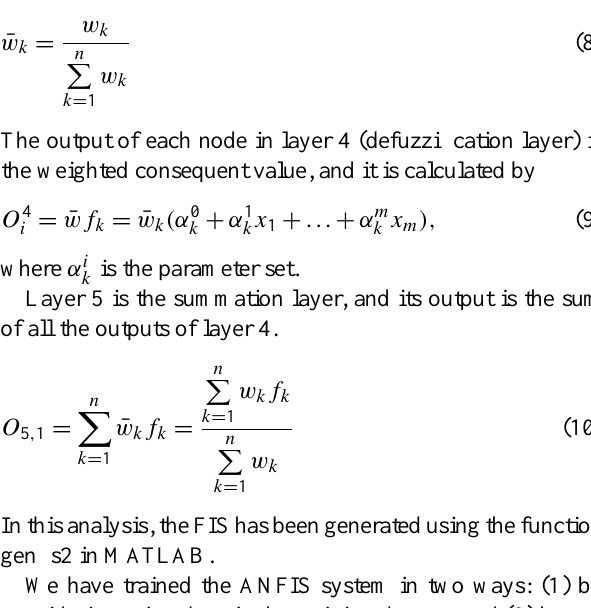
the firing strengths of all the